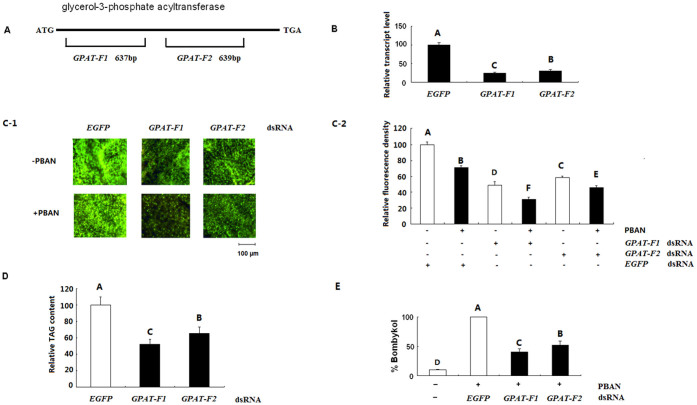
Functional analysis of BmGPAT.(A) Schematic diagram for depicting the location of dsRNA matched to GPAT opening reading frame. (B) qPCR analysis of effects of different dsRNA injection on GPAT transcript level. The rp49 gene was used as the housekeeping gene for normalization in all qPCR analysis. The data represent the mean ± SD of three biological replicates. Significance of comparisons are marked by the different capital letter (ANOVA and Tukey's test, p < 0.01). (C) Effects of RNAi-mediated knockdown of GPAT on LD dynamics. dsRNA (15 μg for each insect) corresponding to different regions of GPAT were injected into the decapitated females 48 h before elcosion, and then injected with 10 pmol PBAN or PBS buffer only for 90 min after a 48 h maintenance period. The EGFP dsRNA was used as negative control. The PGs were dissected for Nile red staining and subsequent photograph. The relative fluorescence density was measured using Quantity One soft. Statistically significant differences are denoted by the different capital letter (ANOVA and Tukey's test, p < 0.01). (D) Effects of RNAi-mediated knockdown of GPAT on PG TAG production. The PGs were dissected 48 h after dsRNA injection as described above and extracted for TAG quantification. Bars indicate the mean ± SD of three biological replicates for independent experimental animals (n > = 12). Statistically significant differences from the EGFP dsRNA–injected females are denoted by the different capital letter determined by ANOVA and Tukey's test (p < 0.01). (E) Effects of RNAi-mediated knockdown of GPAT on bombykol production. The moths 48 h after dsRNA injection as described above were injected individually with PBAN (10 pmol) and maintained for 90 min. The PGs were then dissected and extracted in hexane for bombykol quantification with GC/MS. Bars indicate the mean ± SD of three biological replicates for independent experimental animals (n > = 12). Statistically significant differences from the PBAN alone are denoted by the different capital letter (ANOVA and Tukey's test, p < 0.01).